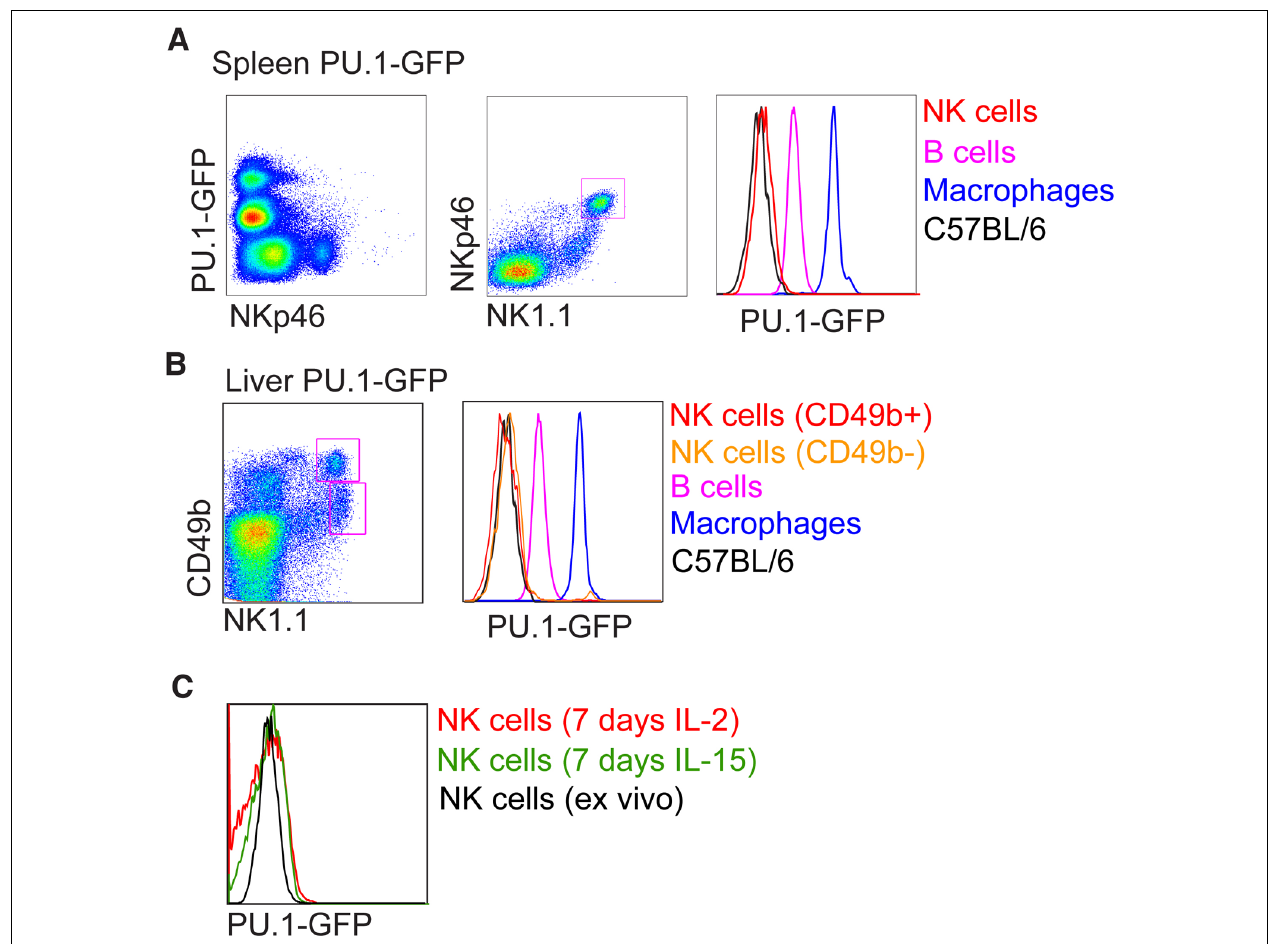
FIGURE 2 |Analysis of PU.1-GFP expression in NK cells from PU.1 reporter mice. Intensity of PU.1-GFP levels in (A) spleen, (B) liver, and (C) in vitro expanded splenic NK cells were determined by fluorescence-activated cell sorter (FACS) and compared to B cells and macrophages from PU.1-GFP reporter mice or NK cells from C57BL/6